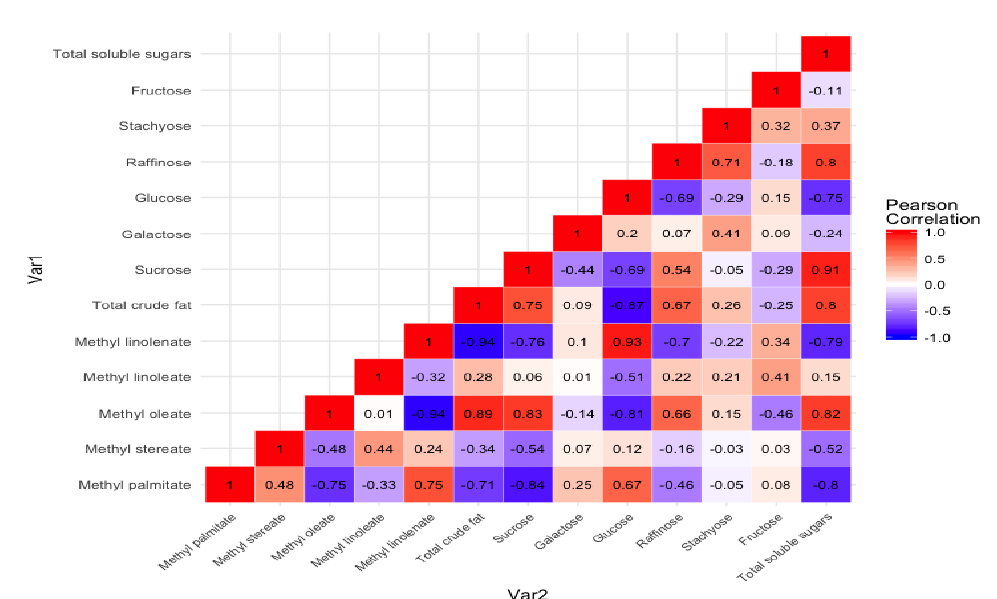
Figure 5. Heatmap showing correlation between total crude fat and total soluble sugar content along with the individual FAMEs and sugar profiles. FAMEs: fatty acid methyl esters.